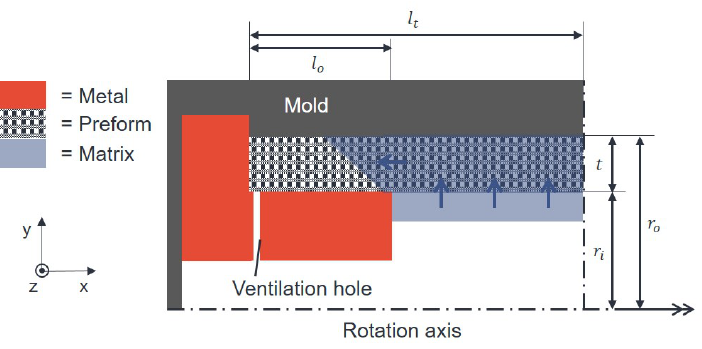
Figure 2. Impregnation in the rotational molding process